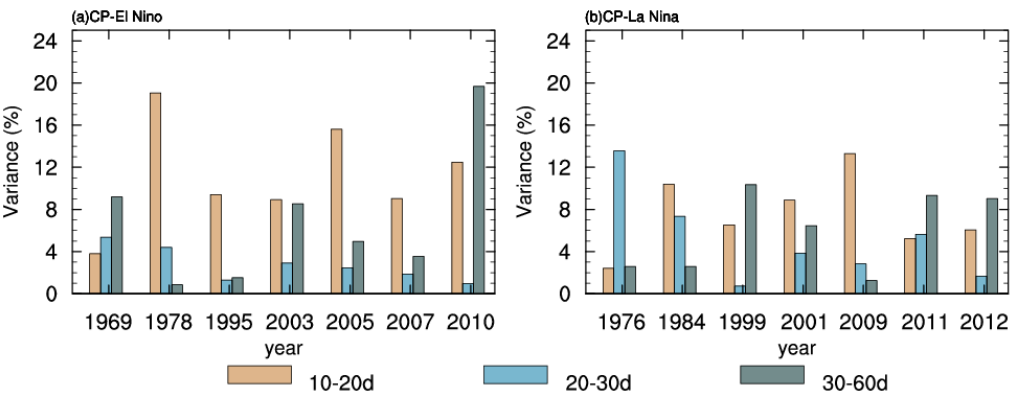
Figure 3. The variance contribution of low-frequency oscillation components accounting for the total summer precipitation variability of CP El Niño ( a ) and CP La Niña ( b ) (unit:%).